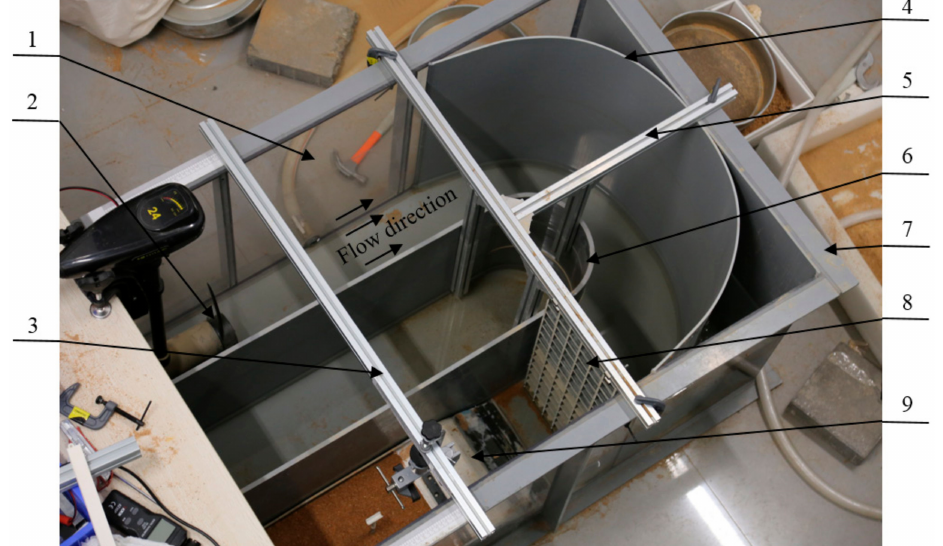
Figure 7. The rotation of the turbine model was driven by a direct current (DC) motor connected to a ◦ universal joint to allow for 90 of torque transmission.